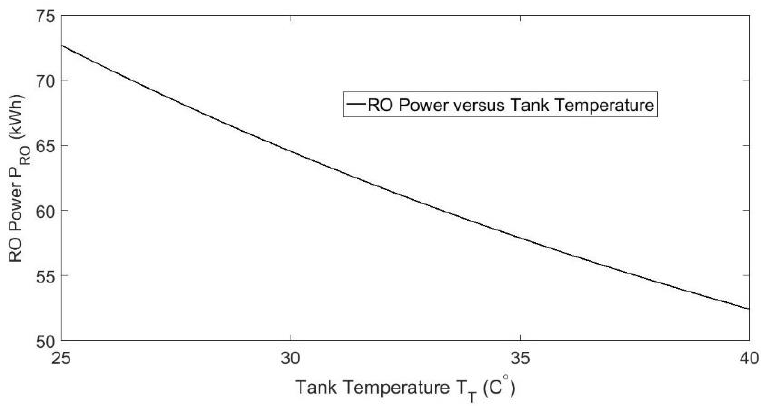
Figure 4. RO pumping power versus brackish water temperature in the storage tank.